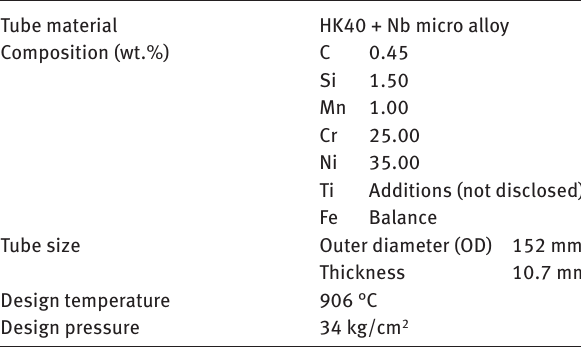
Table 8: Material specification and design parameters of reformer tubes [30].